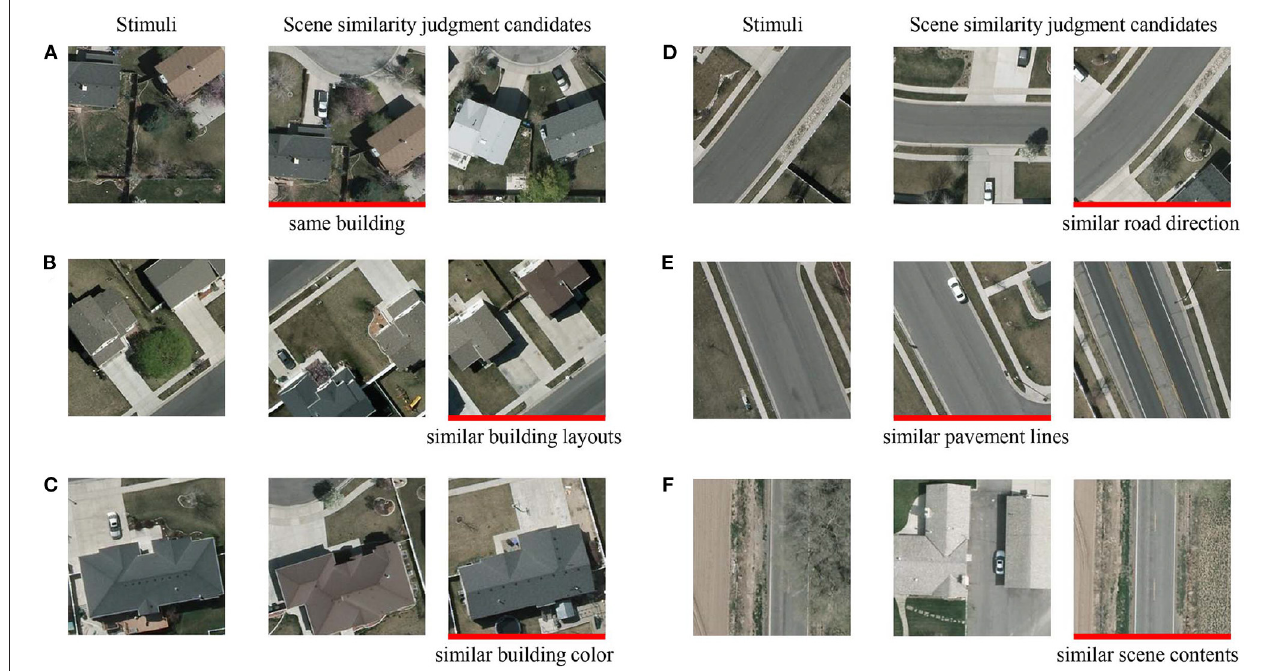
FIGURE 3 | Examples of the two-alternative forced-choice scene similarity judgment questions. Red markers under the candidates indicate that their scenes were more similar to that of their corresponding stimuli due to the presence of the same building (A) , similar building layouts (B) , similar building color (C) , similar road direction (D) , similar pavement lines (E) , or similar scene contents (F)